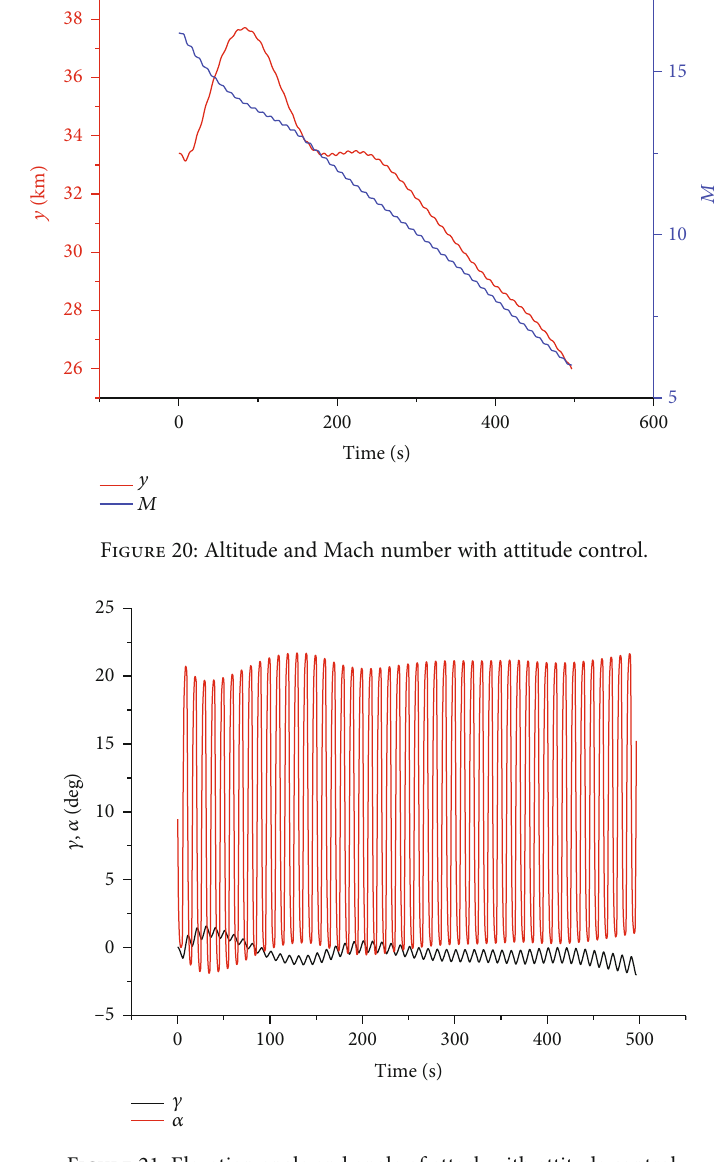
Figure 21: Elevation angle and angle of attack with attitude